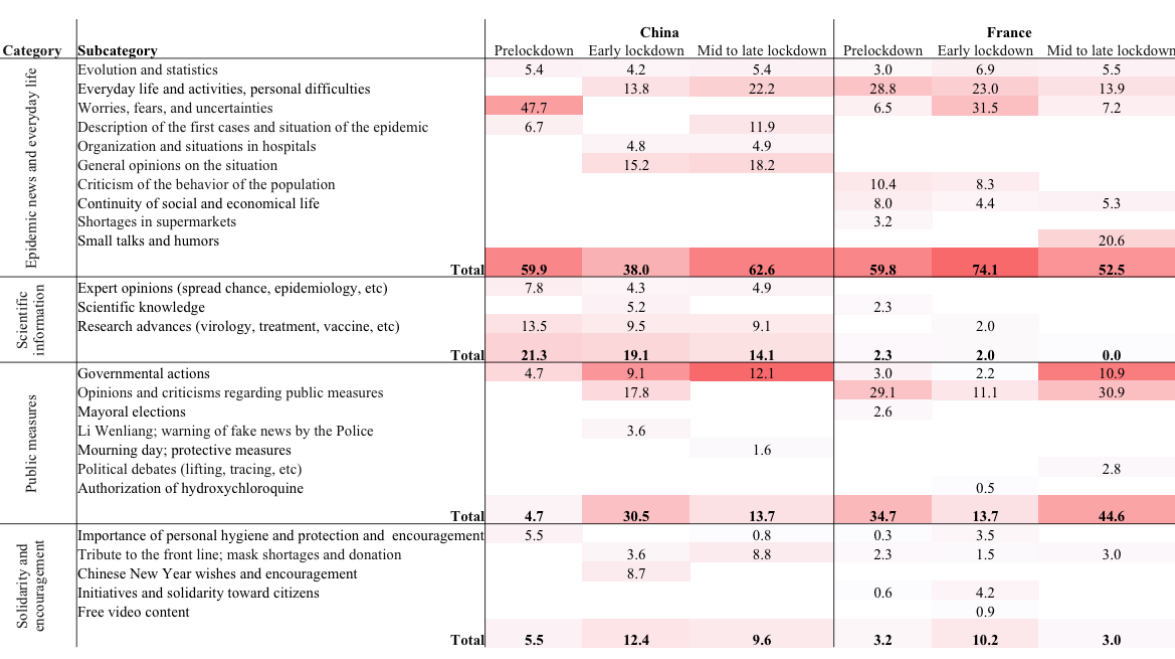
Figure 2. Comparison between topics on Weibo and Twitter. The percentage of messages of each category and subcategory were shown for all three periods in both countries. The color reflected the